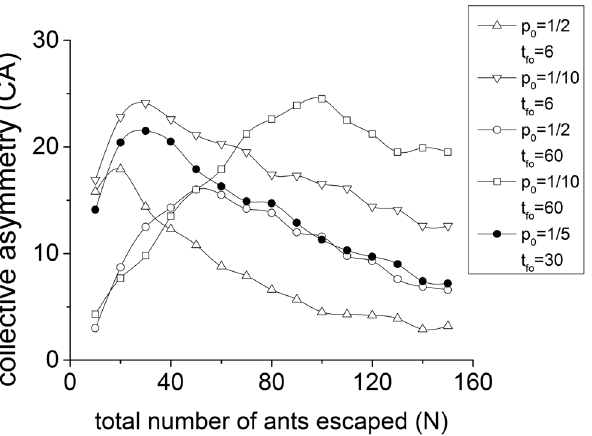
Fig. 7. CA u s : N of alarm pheromone model. The solid dots denote the best-fit simulation result with the following parameters: p 0 ~ 1 = 5 and t fo ~ 30 seconds . The others denote 4 combinations of different parameters when p 0 is assigned a value of 1/2 and 1/10, and t fo is assigned a value of 6 and 60 seconds. This demonstrates that the initial increasing and then decreasing pattern is robust. All the points are averaged over 1000 runs.